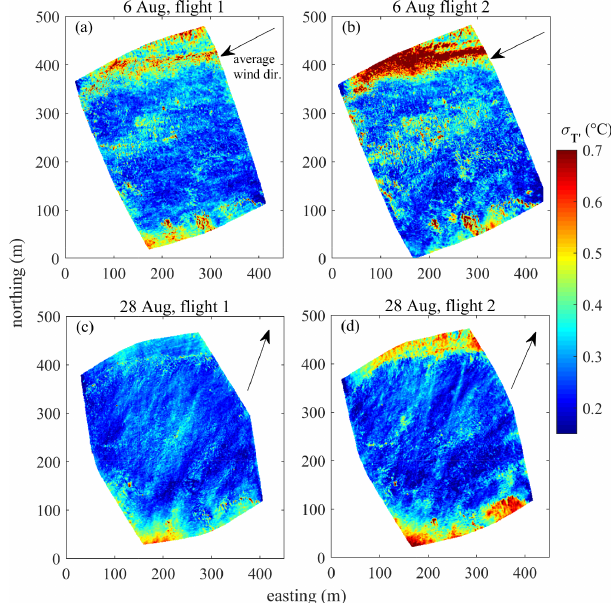
Figure 6. Maps of σ T (cid:48) . The arrows show the mean wind direction during the flight.